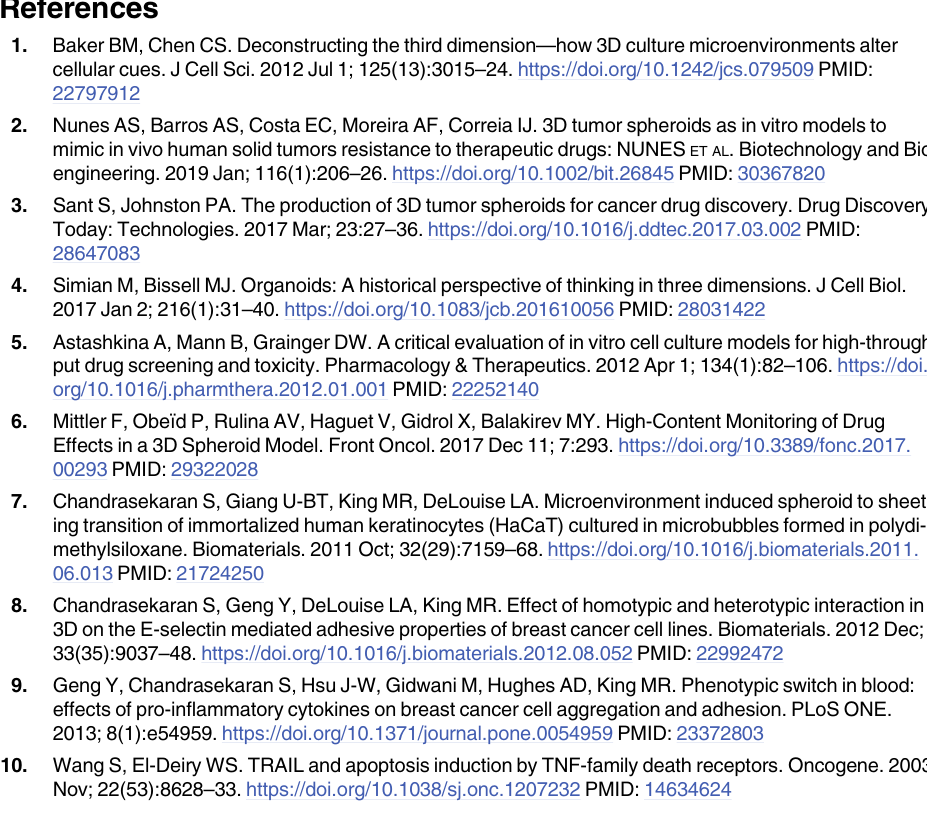
S1 Fig. Original images for Western blots and gels. (PDF) S2 Fig. Mycoplasma test results via Mycoplasma detection kit (ATCC